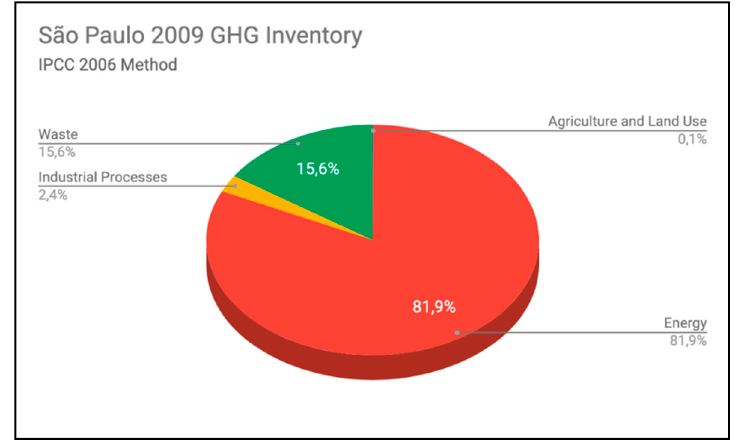
Figure 5. São Paulo’s 2009 GHG inventory [54]. Figure 5. S ã o Paulo’s 2009 GHG inventory Table 5. State- and city-level GHG inventories * [51–57] .